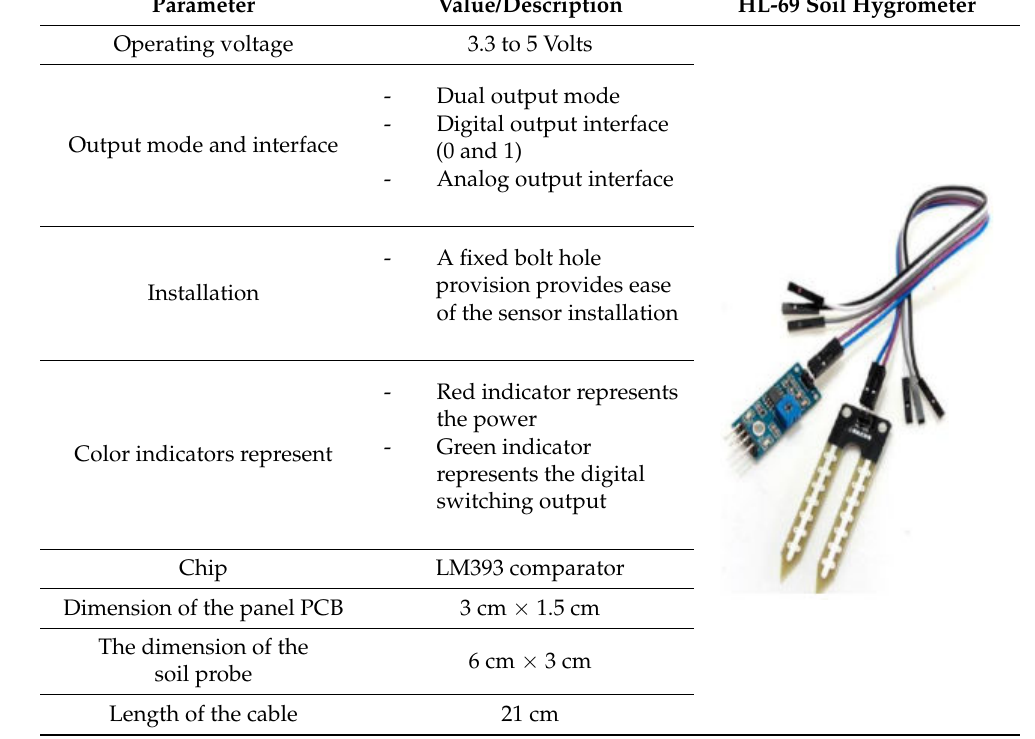
Table 2. Features of the HL-69 Soil Hygrometer (Note: PCB: printed circuit board).